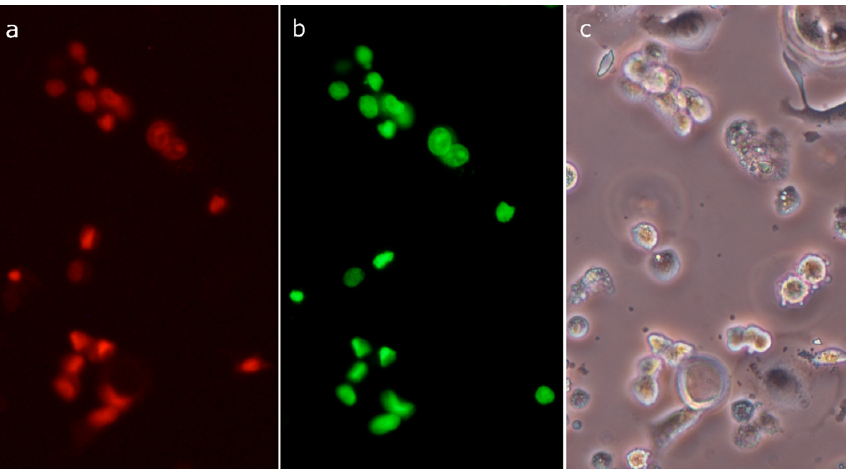
Figure 9. Imaging of active caspases in SK-BR-3 cell line treated with 30 µM compound 4 for 6 h, using an Image-iT™ LIVE Red Poly Caspases Detection Kit: active caspases visualized using FLICA reagent (FAM-VAD-FMK poly caspases reagent) ( a ); dead cells permeable to SYTOX Green nucleic acid stain ( b ); the same area as in the previous photographs seen in phase-contrast microscopy ( c ).